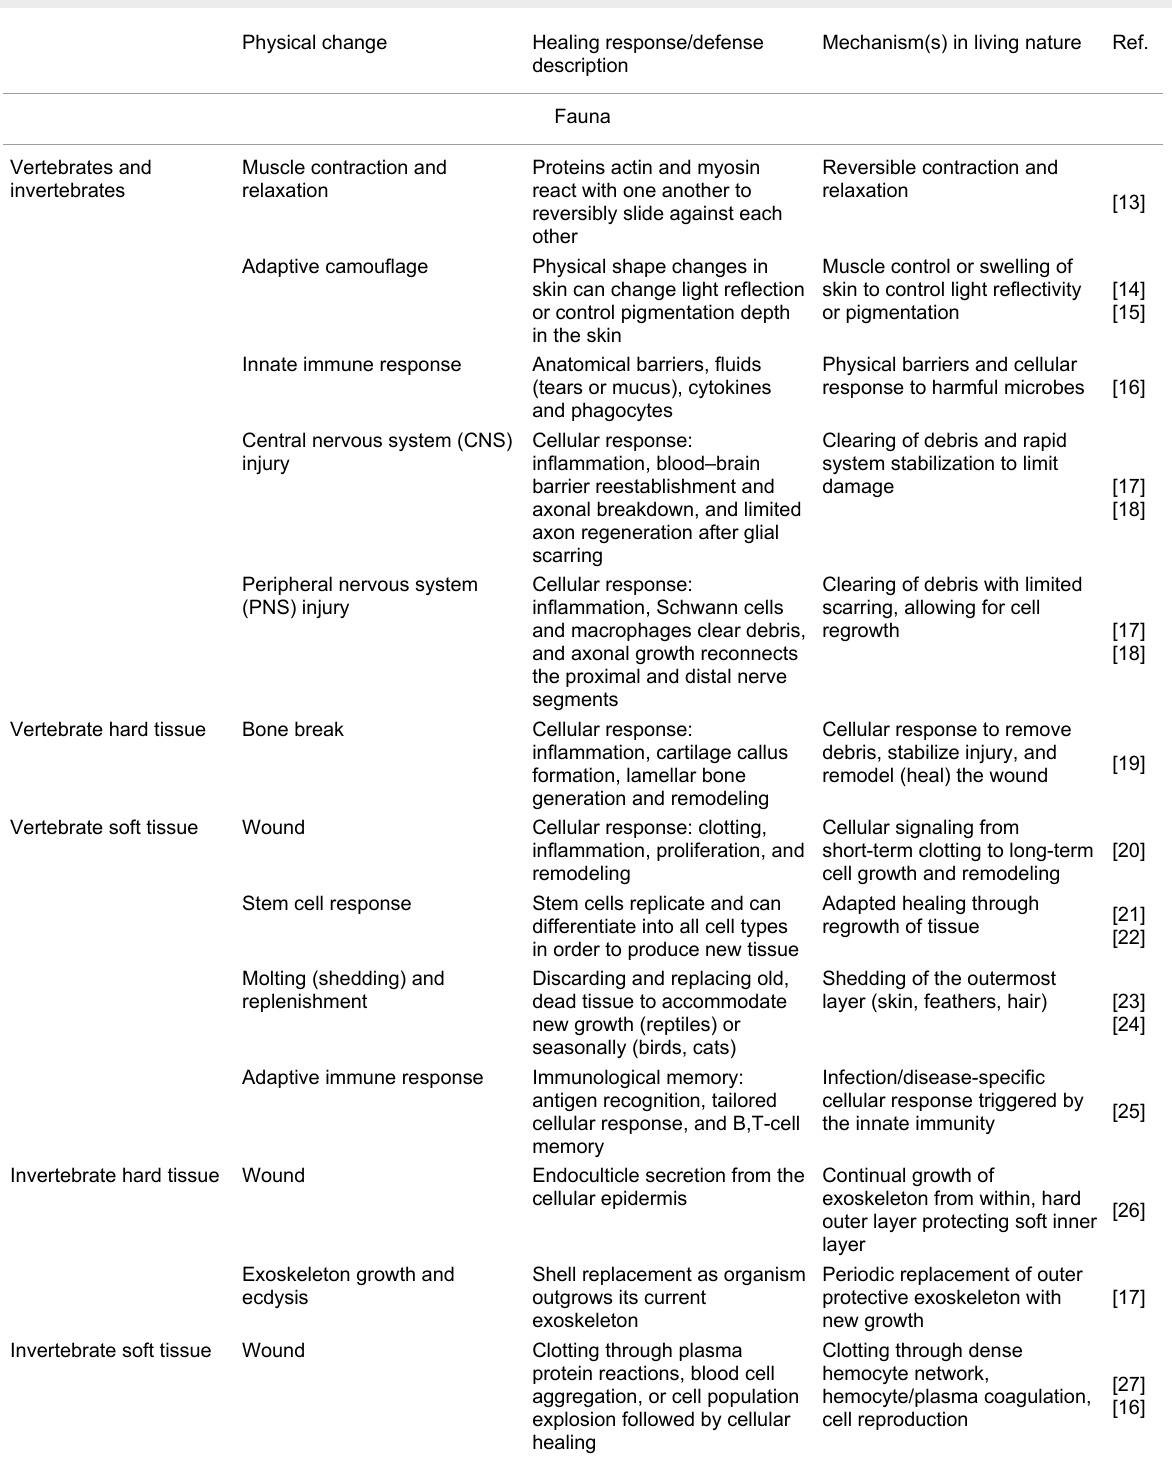
Table 1: Self-healing and defense mechanisms found in living